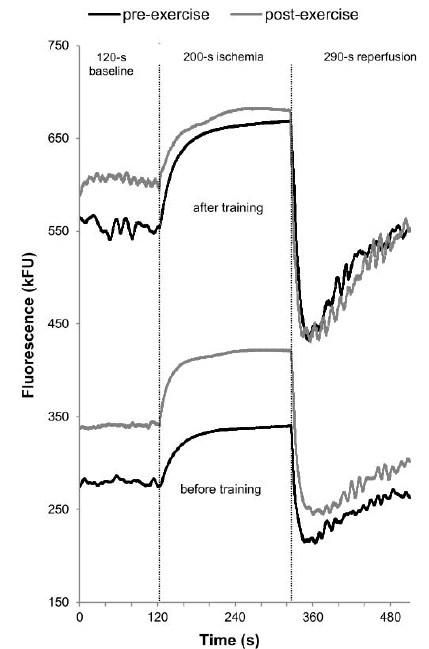
Figure 1. Parameters describing the Flow Mediated Skin Fluorescence. B mean —Mean value of the basal fluorescence; FI max —Maximal fluorescence during ischemia; FR min —The first minimal fluorescence value during reperfusion; I max —The net increase in fluorescence over the baseline during ischemia; IR ampl —The amplitude of fluorescence change during ischemia and reperfusion; R min —The net reduction in fluorescence below the baseline. Reprinted from Bugaj et al. [5]. The second measurement was made according to the same methodology, 3 min after the end of the treadmill test. A sample measurement of the NADH fluorescence from a 23-year-old male sprinter before and after training was shown in Figure 2.